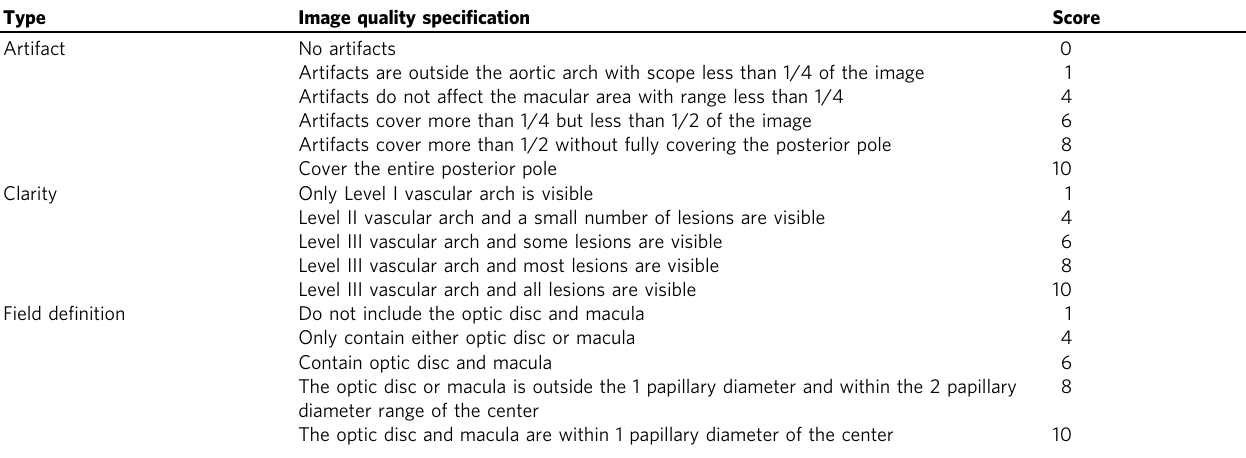
Table 5 Image quality scoring